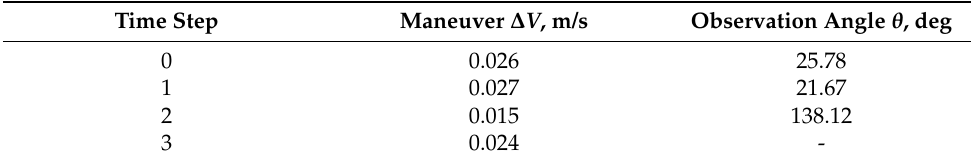
Table 6. The characteristic of the nominal trajectory for  r o b u s t .